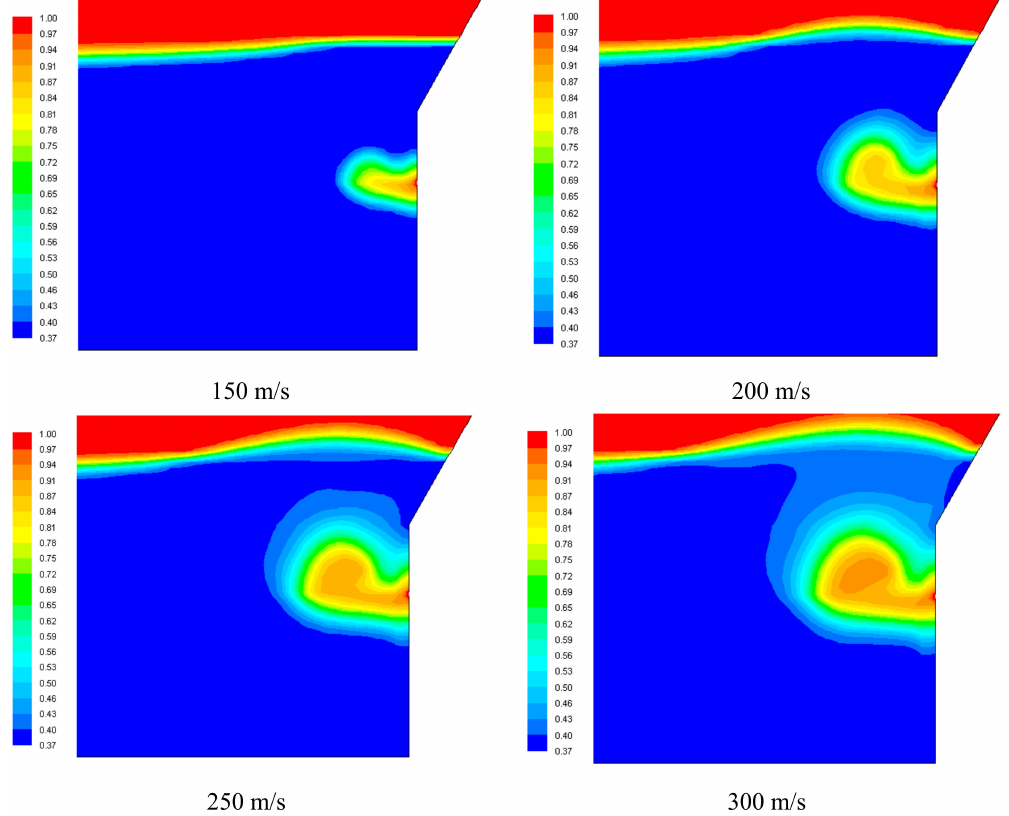
Figure 6. Gas phase volume fraction fractions at di ff erent blowing